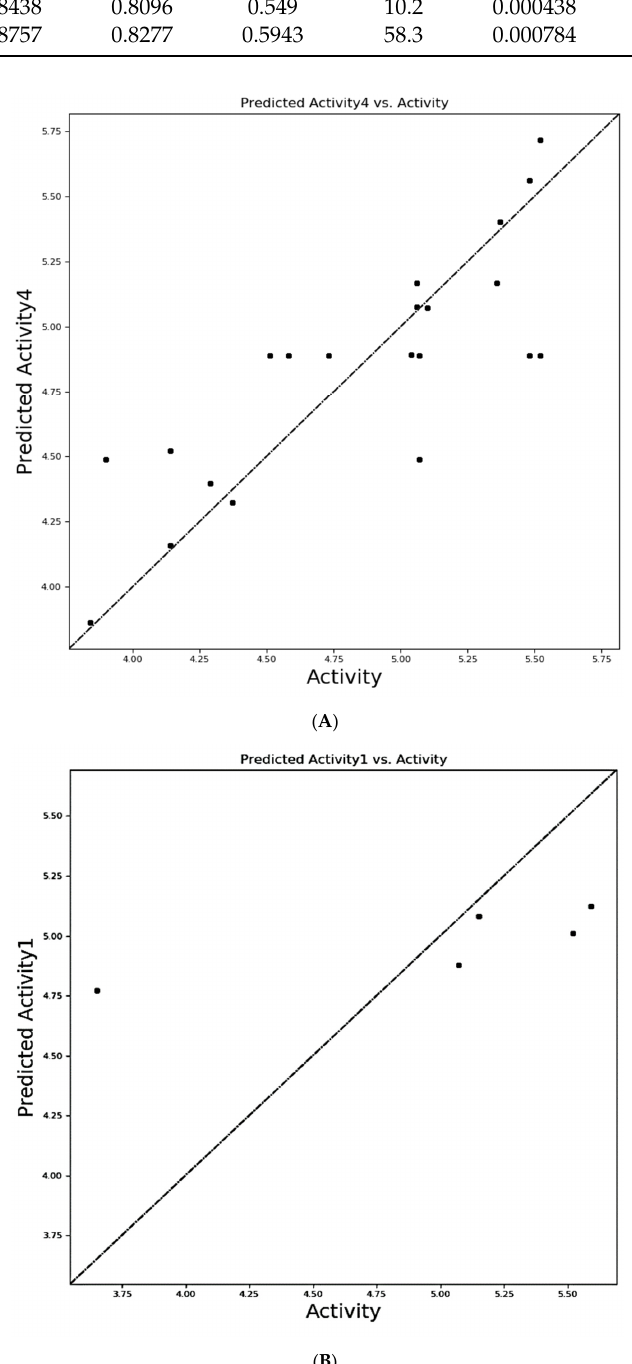
Figure 4. Scattered plot of experimental vs. predicted activity of training set ( A ) and test set ( B ) molecules, where the filled circles represent the training and test set compounds,